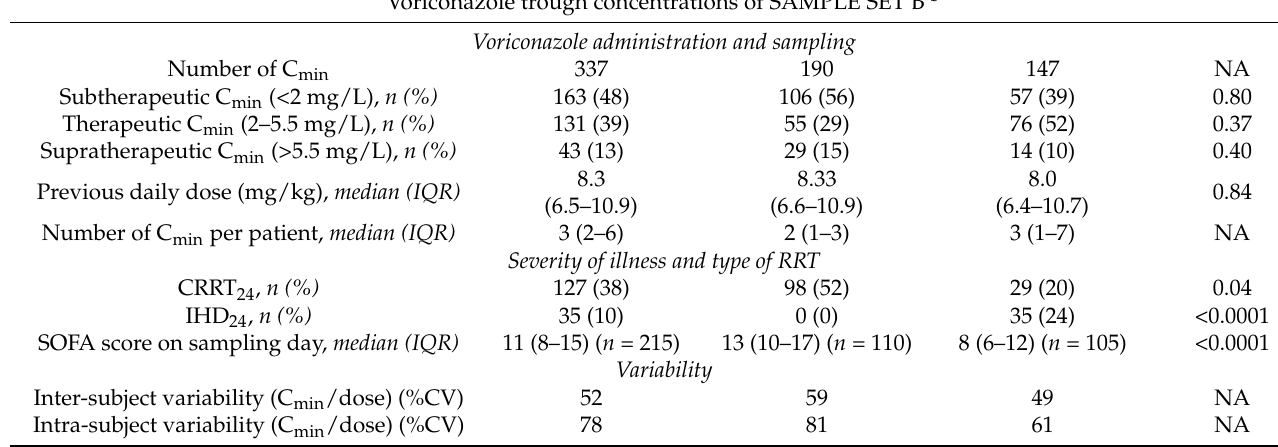
(pre, during and post ECMO) and Figure S2, the voriconazole dose in function of the day of ECMO is